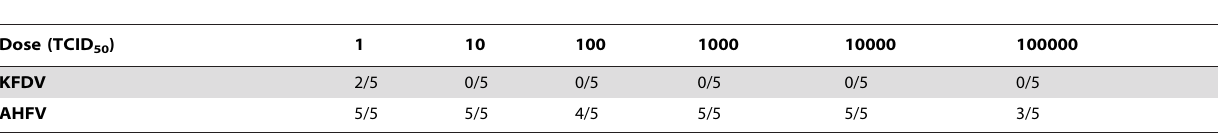
Table 1. Survival data for C57BL/6 mice following infection with KFDV or AHFV sc.